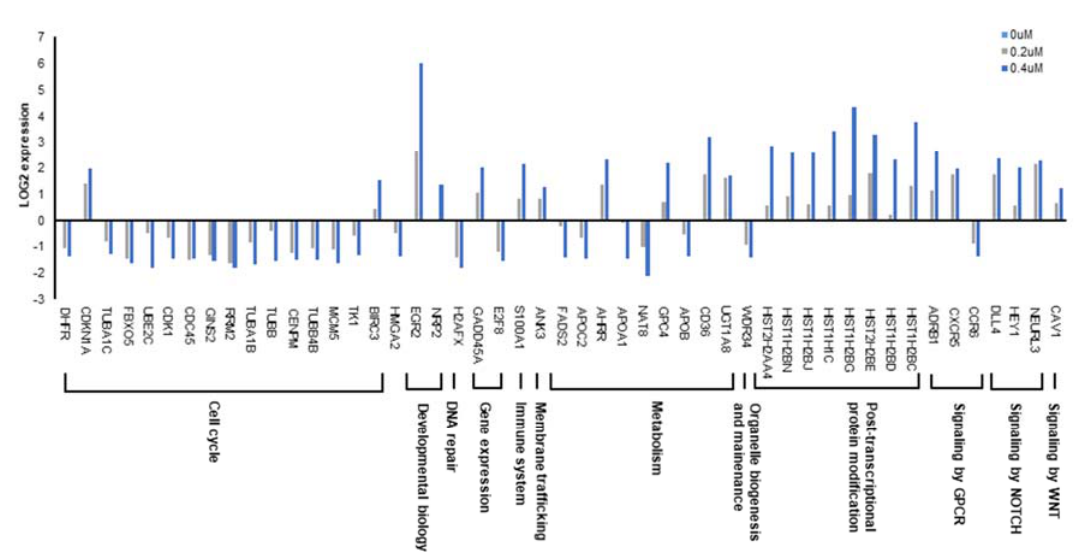
Genome-wide expression of the indicated signal pathway-related genes in Huh7 cells treated with 200 nM or 400 nM CPO determined by RNA-sequencing Figure 5. RNA ‐ seqeuncing (RNA ‐ seq) profiling reveals a novel target pathway of CPO in HCC. Genome ‐ wide expression of the indicated signal pathway ‐ related genes in Huh7 cells treated with 200 nM or 400 nM CPO determined by RNA ‐ sequencing analysis.